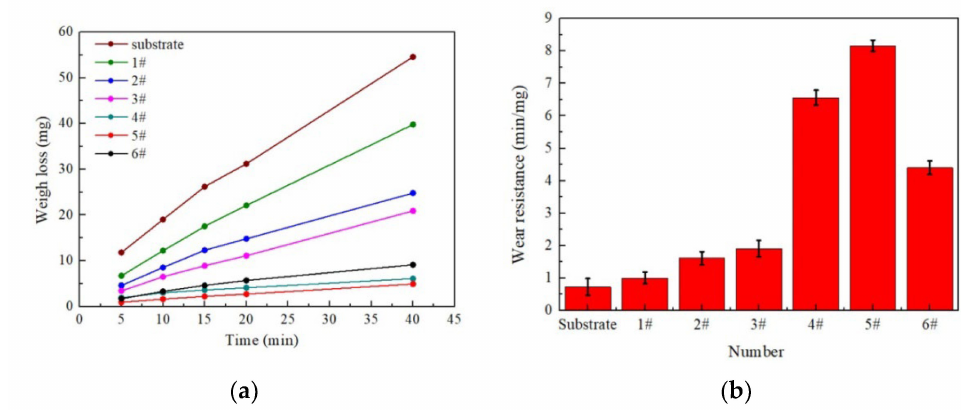
Figure 24. ( a ) Mass loss of different cladding layers and ( b ) the wear resistance of different cladding